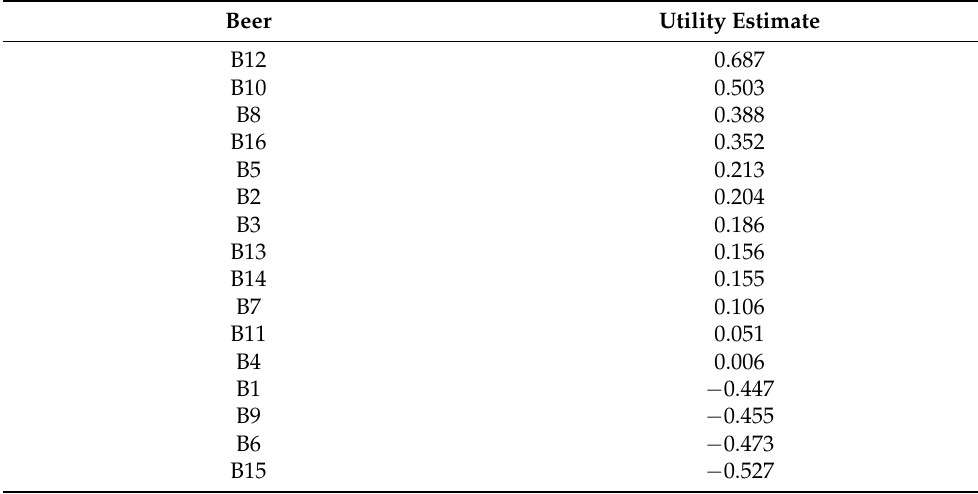
Table 10. Stimulus ranking.